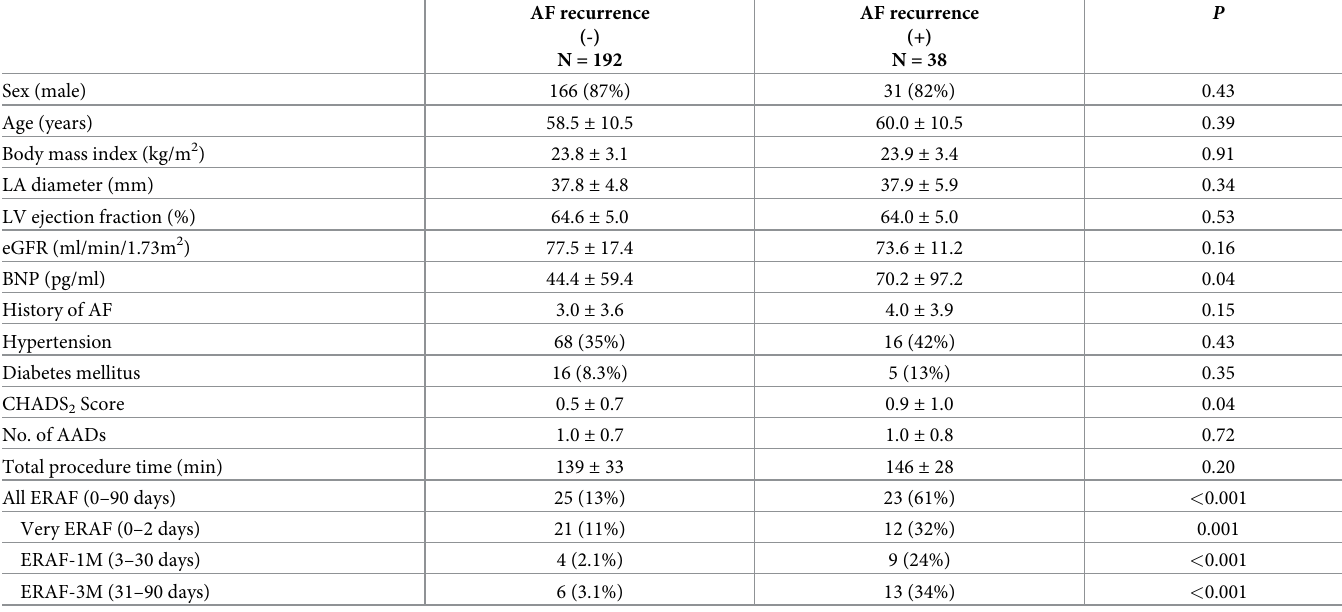
Table 3. Comparison of the cases with and without true AF recurrence after cryoballoon ablation.